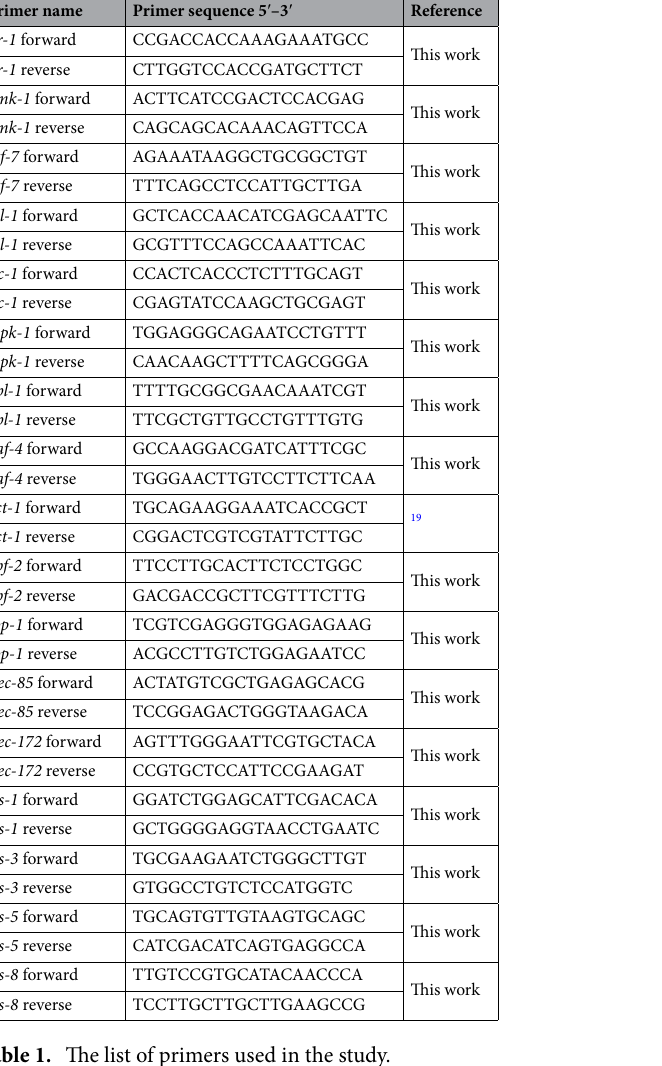
Table 1. The list of primers used in the